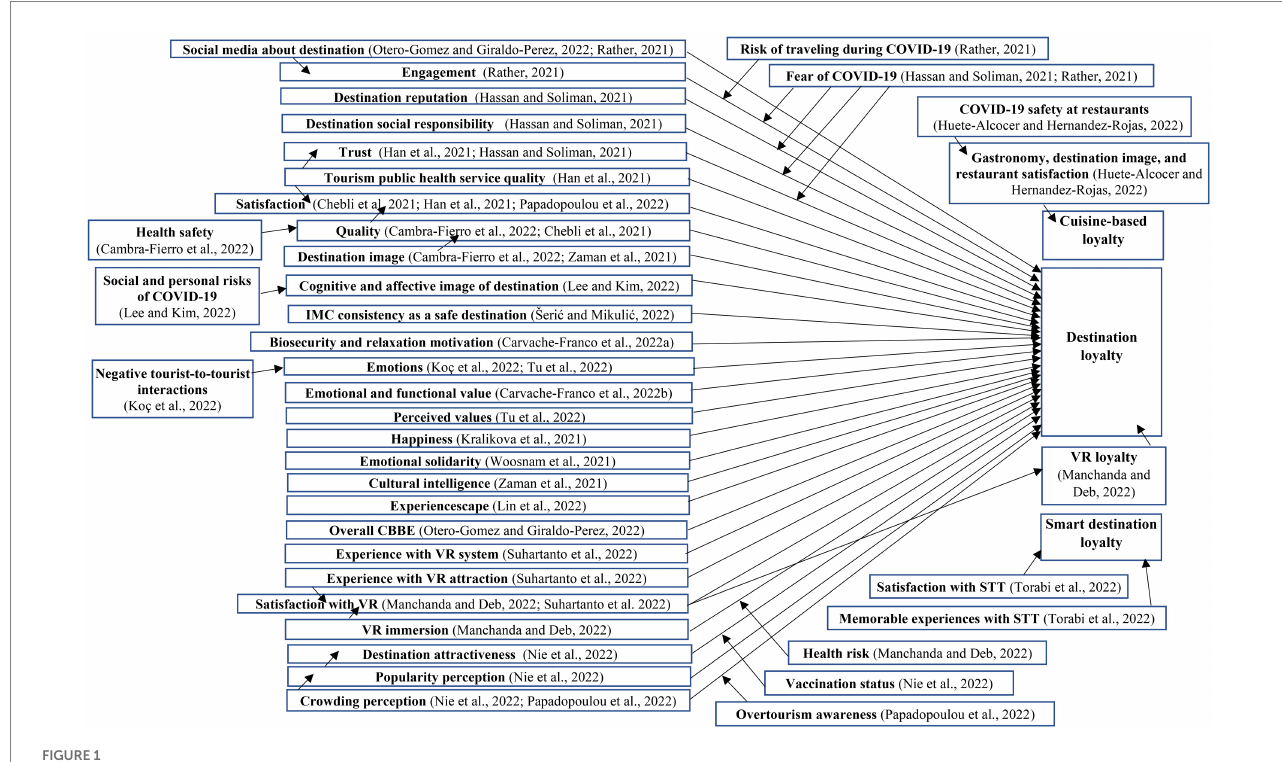
FIGURE 1 Drivers of destination